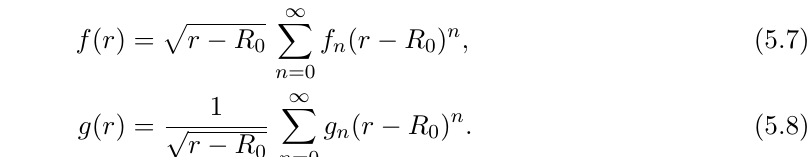
= 10 for different values of z 0